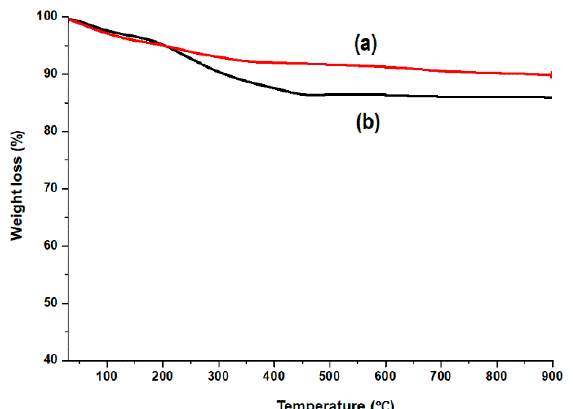
Figure 3. TGA thermograms of ( a ) pristine SPIONs and ( b ) CLA-coated SPIONs demonstrating weight loss (%) over a temperature range of 30–900 °C.